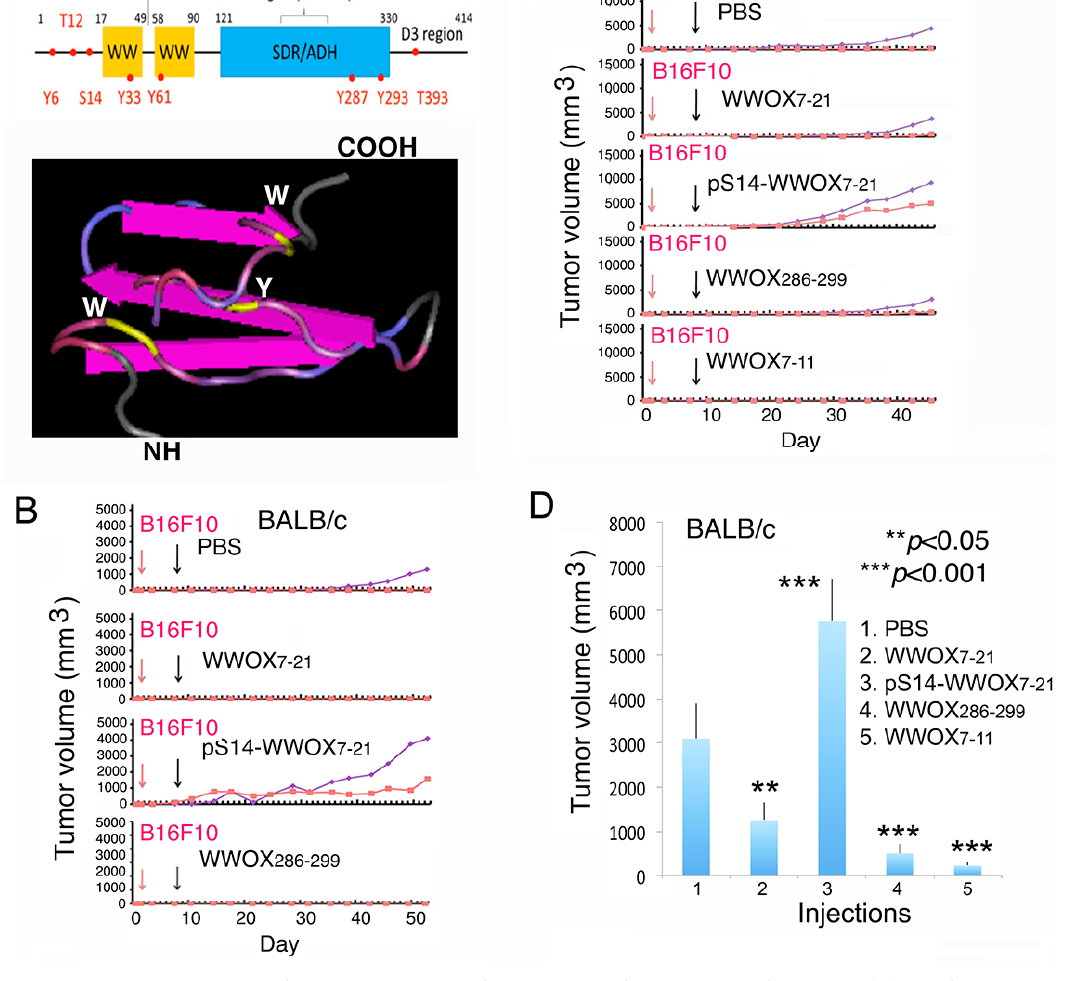
Figure 1. WWOX7-21 and WWOX7-11 peptides suppressed cancer growth in vivo. ( A ) A schematic primary structure of the first WW domain of WWOX is shown. ( B , C ) BALB/c mice were inoculated with B16F10 melanoma cells in the left and right flanks (red and blue lines of growth curves). A week after, mice received indicated peptides (1 mM in 100 µL PBS) via tail vein injections. WWOX7-21, WWOX7-11 and WWOX286-299 blocked B16F10 growth. pS14-WWOX7-21 was ineffective. ( D ) The end-point tumor volumes are shown ( n = 6; mean ± SD).